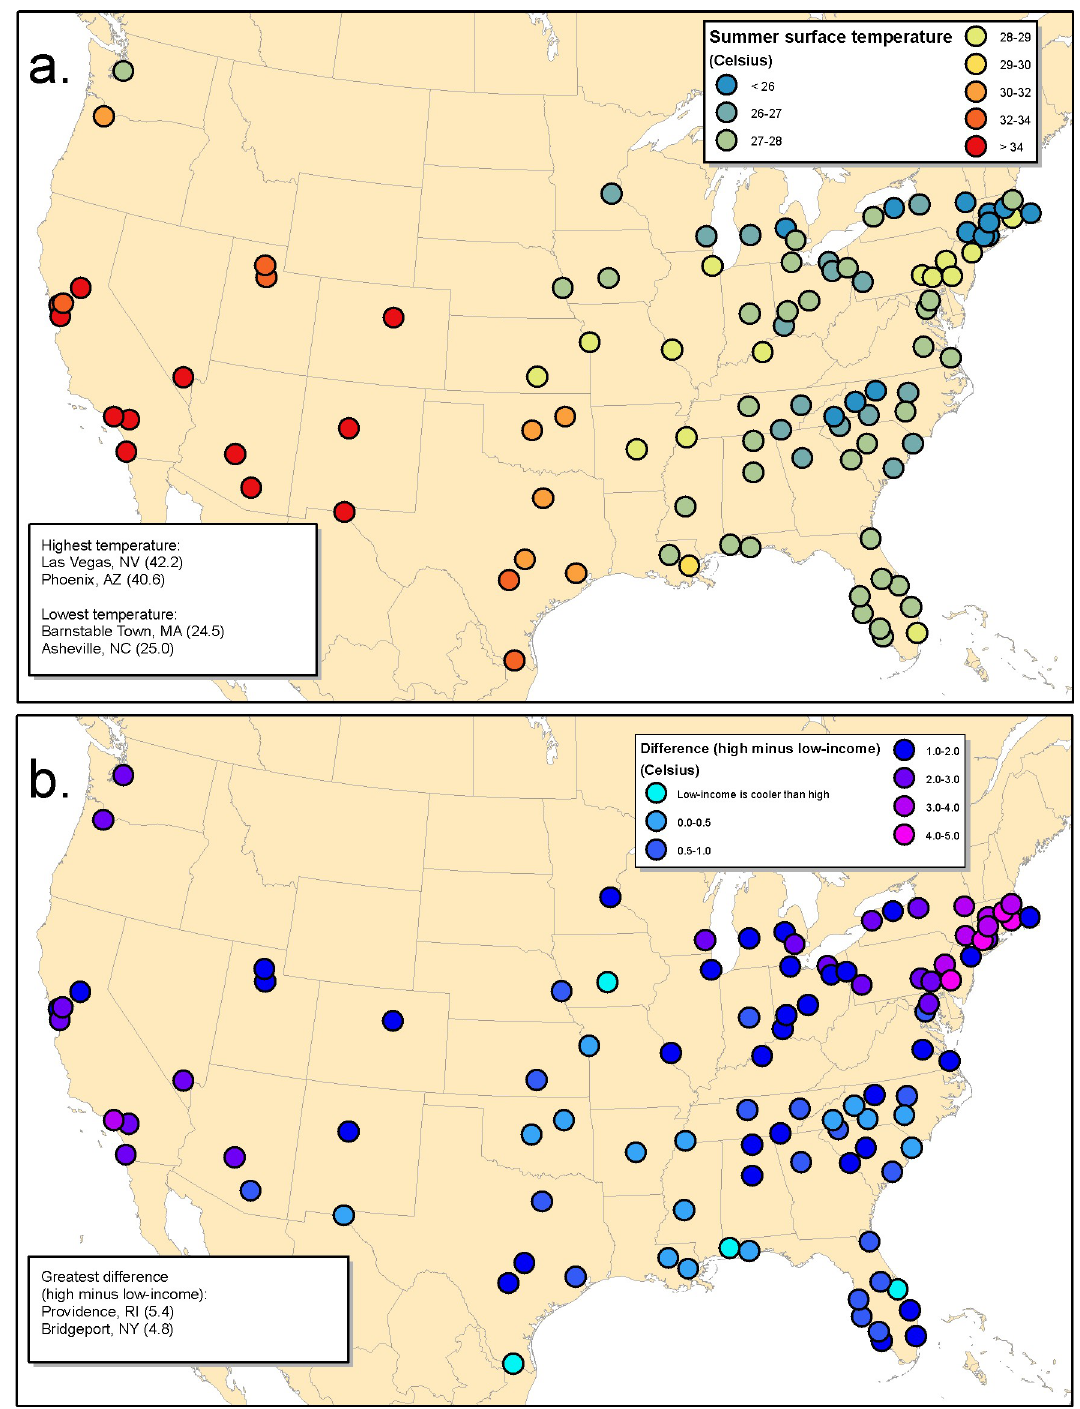
Fig 5. Surface temperature for United States large urbanized areas. a.) Population-weighted median summer surface temperature. b.) The absolute difference in summer surface temperature between low-income blocks (lowest quartile of income) and high-income blocks (highest quartile of